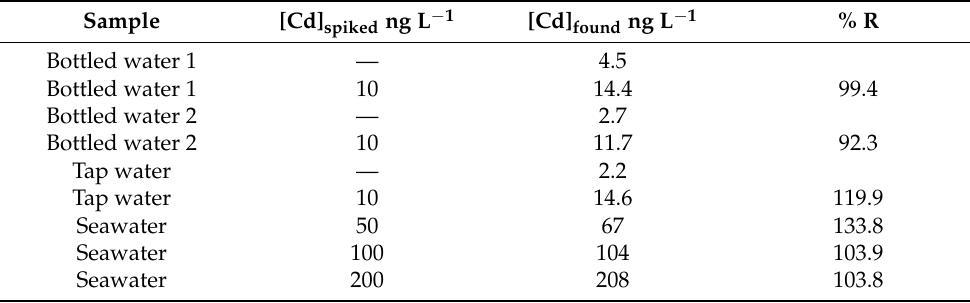
Table 3. Cadmium concentration obtained in different water